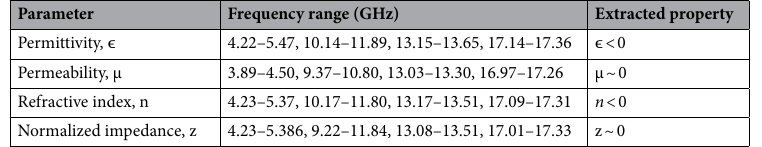
Table 4. Extracted data for the proposed unit cell.